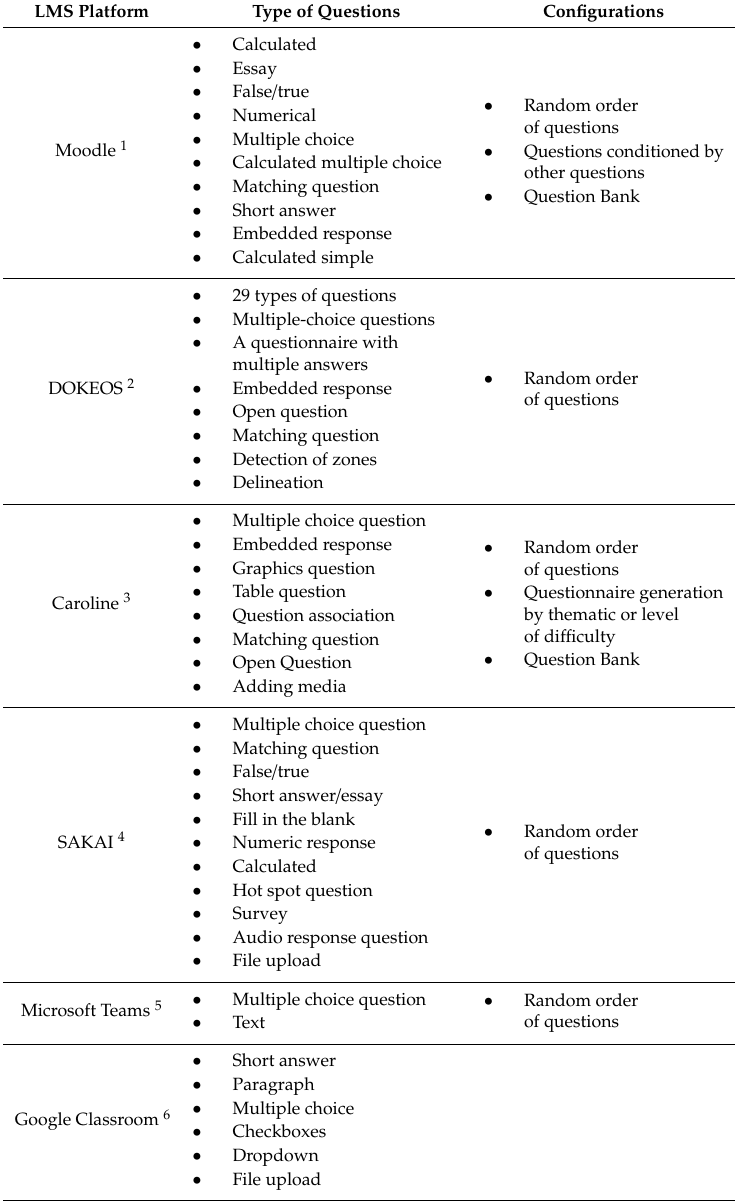
Table 6. LMS evaluation tools: type of questions and general configuration supported by Moodle, DOKEOS, Caroline, SAKAI, Microsoft Teams, and Google